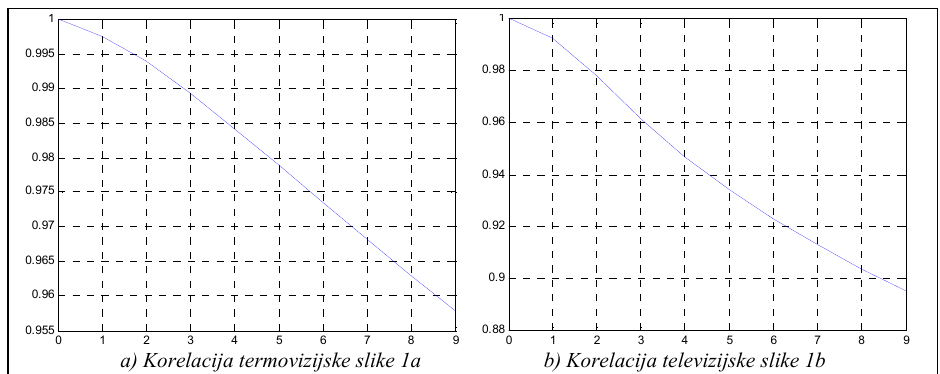
Iz tabele 1 vidi se da termovizijska standardnu devijaciju nivoa sivog od televizijske slike iste scene. Srednja vrednost i entropija termovizijske slike su nešto manje od istih parametara tele- vizijske slike iste